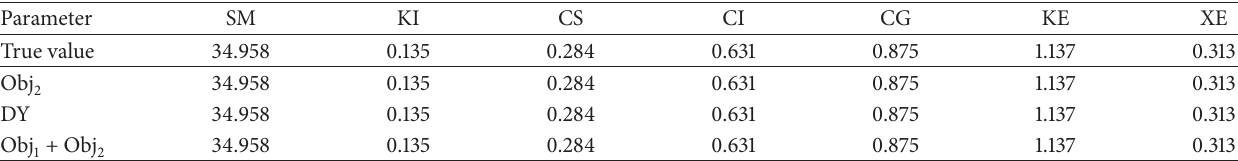
Table 6: Parameter optimization results for the flood simulation.